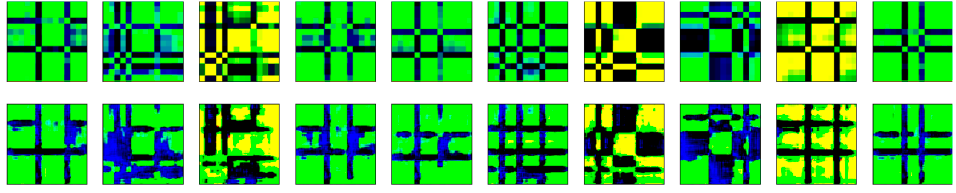
Figure 10. The comparison of image enhancement effects of six datasets. Ten images in each dataset were randomly selected for comparative display. In the enhanced images, the blurred noise points were reduced, and the contour edge was clearer than the original images. The texture features of the images were enhanced by the wavelet transform method.